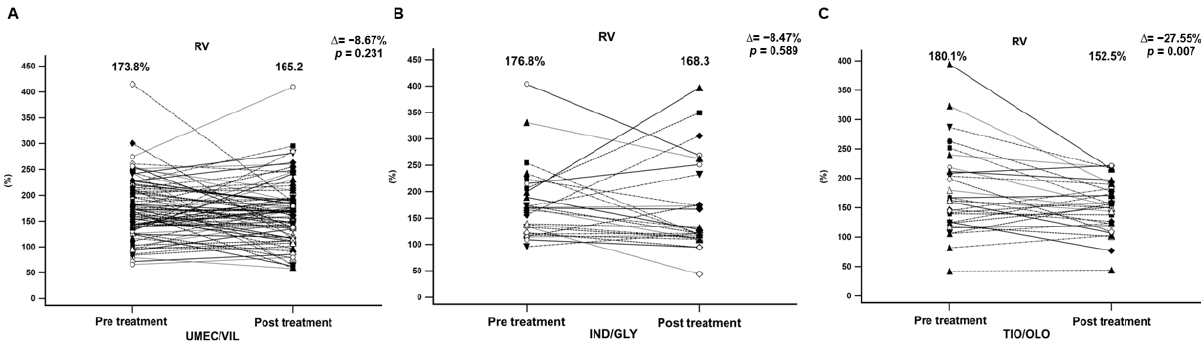
Figure 3. The significant difference in FVC(L) and FVC (%) in COPD patients before and after 12 months of treatment with medications ( A ) FVC(L) in UMEC/VIL, ( B ) FVC(L) in IND/GLY, ( C ) FVC(L) in TIO/OLO, ( D ) FVC(%) in UMEC/VIL, ( E ) FVC(%) in IND/GLY, and ( F ) FVC(%) in TIO/OLO. Data were presented as mean and standard deviation.